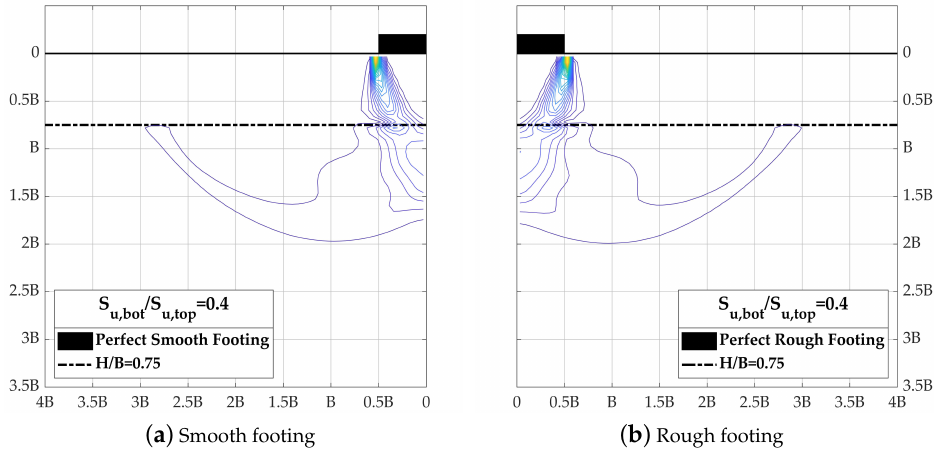
Figure 19. Maximum shear strain rate at the numerical limit load ( H / B = 0.75, S u , bot / S u , top =